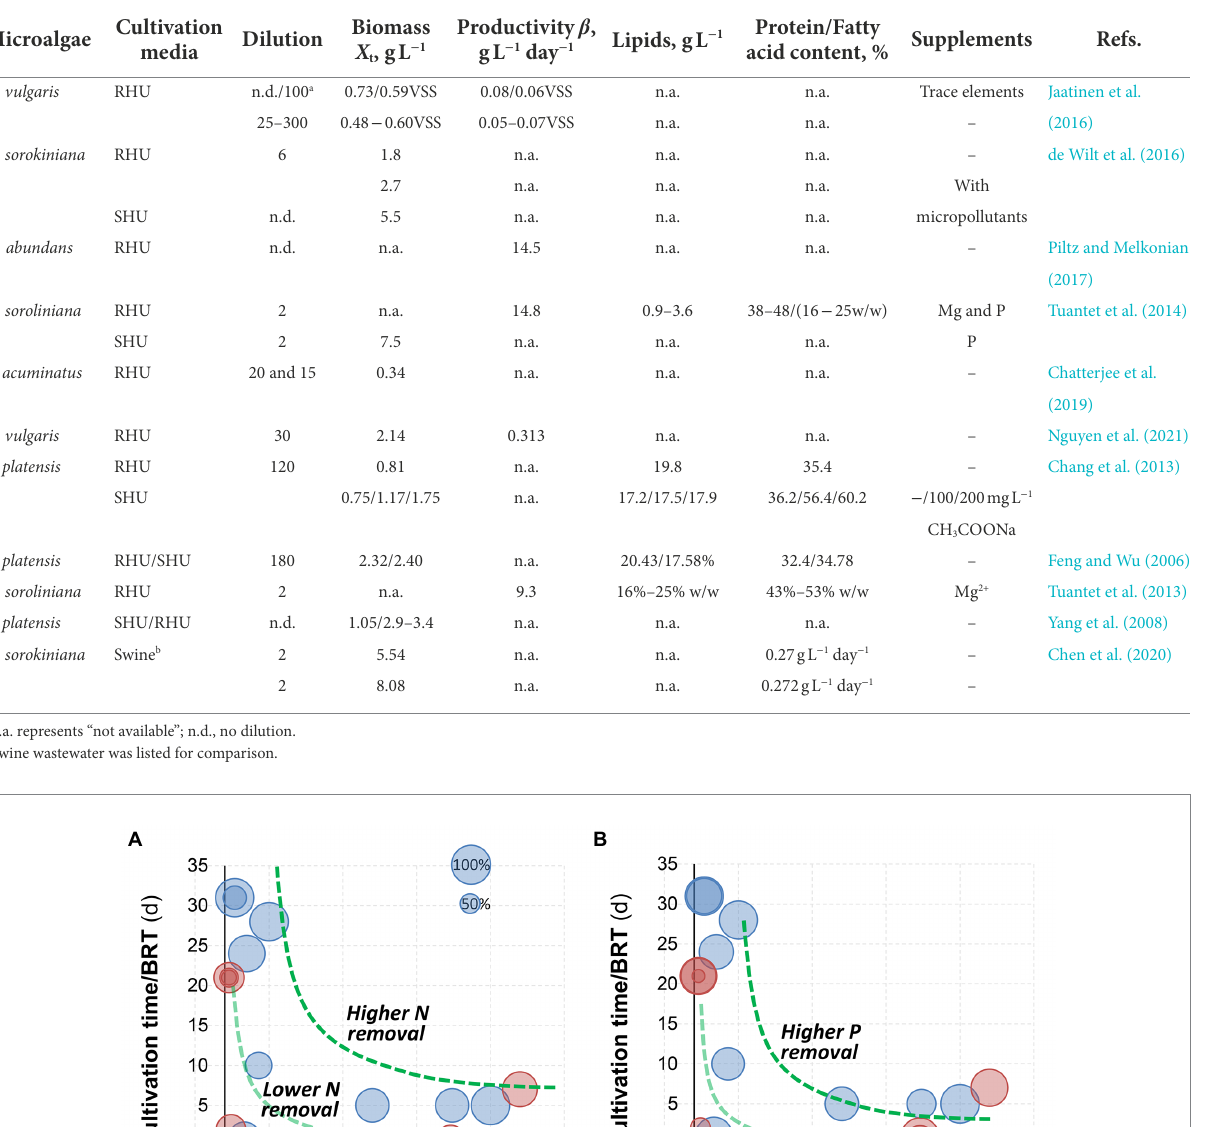
TABLE 3 The performance of microalgae production in urine.